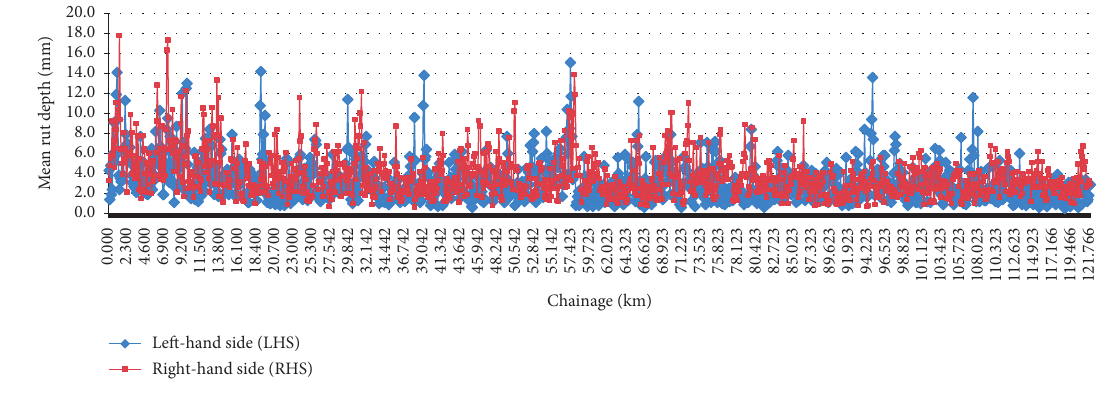
Figure 4: Rutting trend along the road.